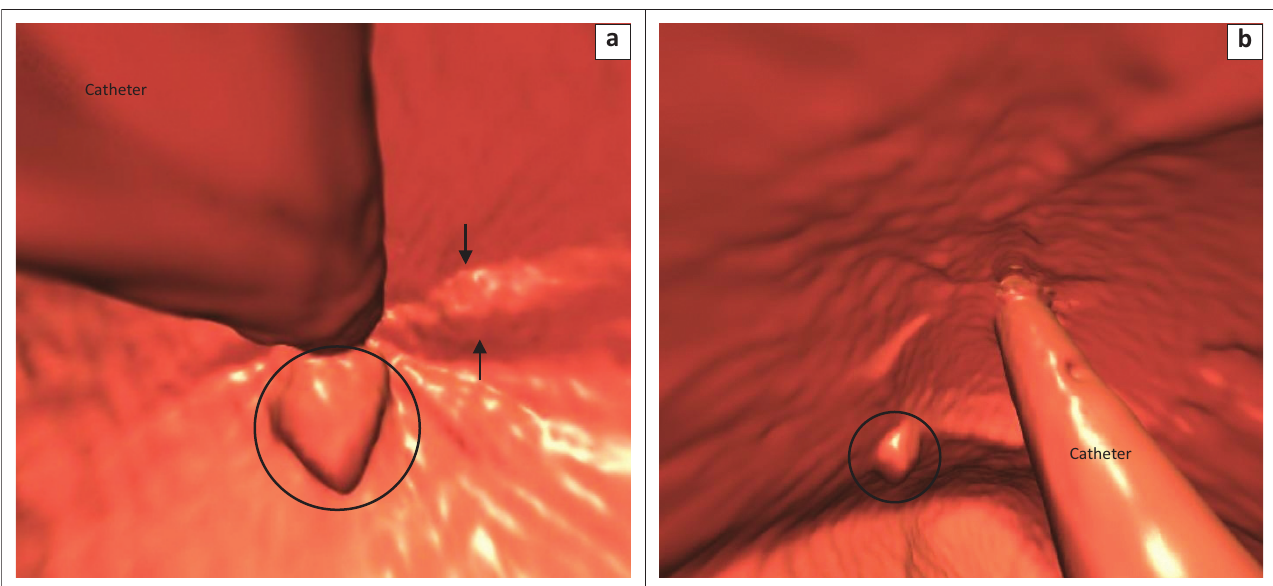
FIGURE 14: (a) 3D image showing linear internal haemorrhoids (black arrows) and anal papilla (circle) in close proximity to the catheter; (b) 3D image of a polyp (circle) away from the